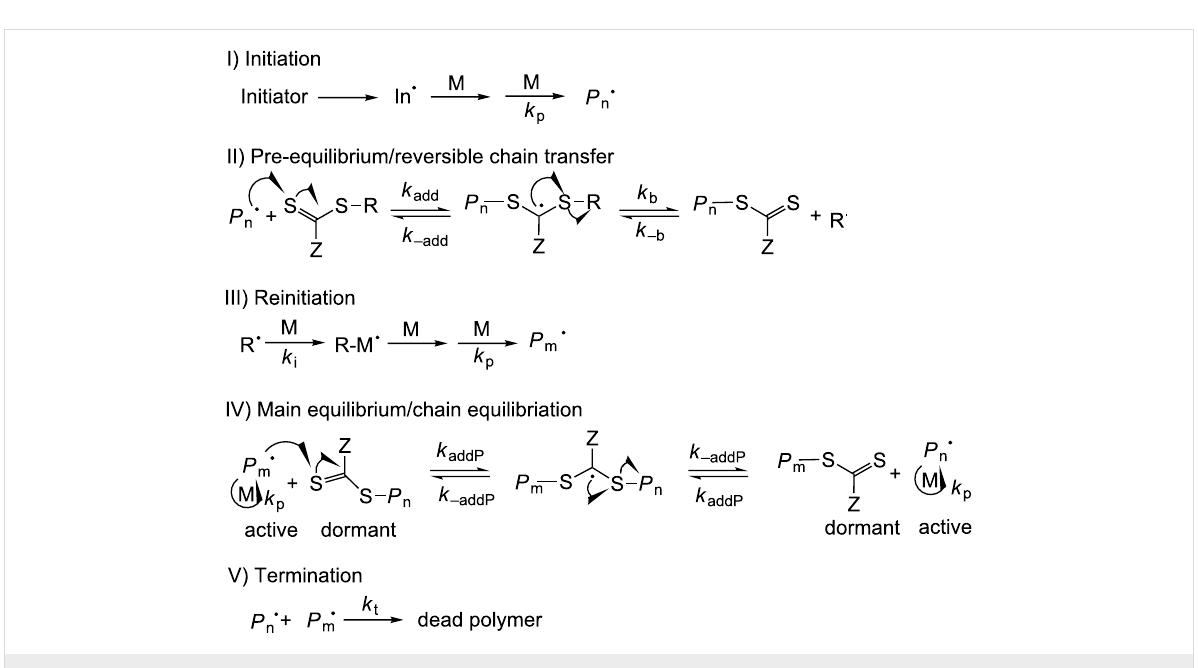
Scheme 3: Mechanism of RAFT polymerization